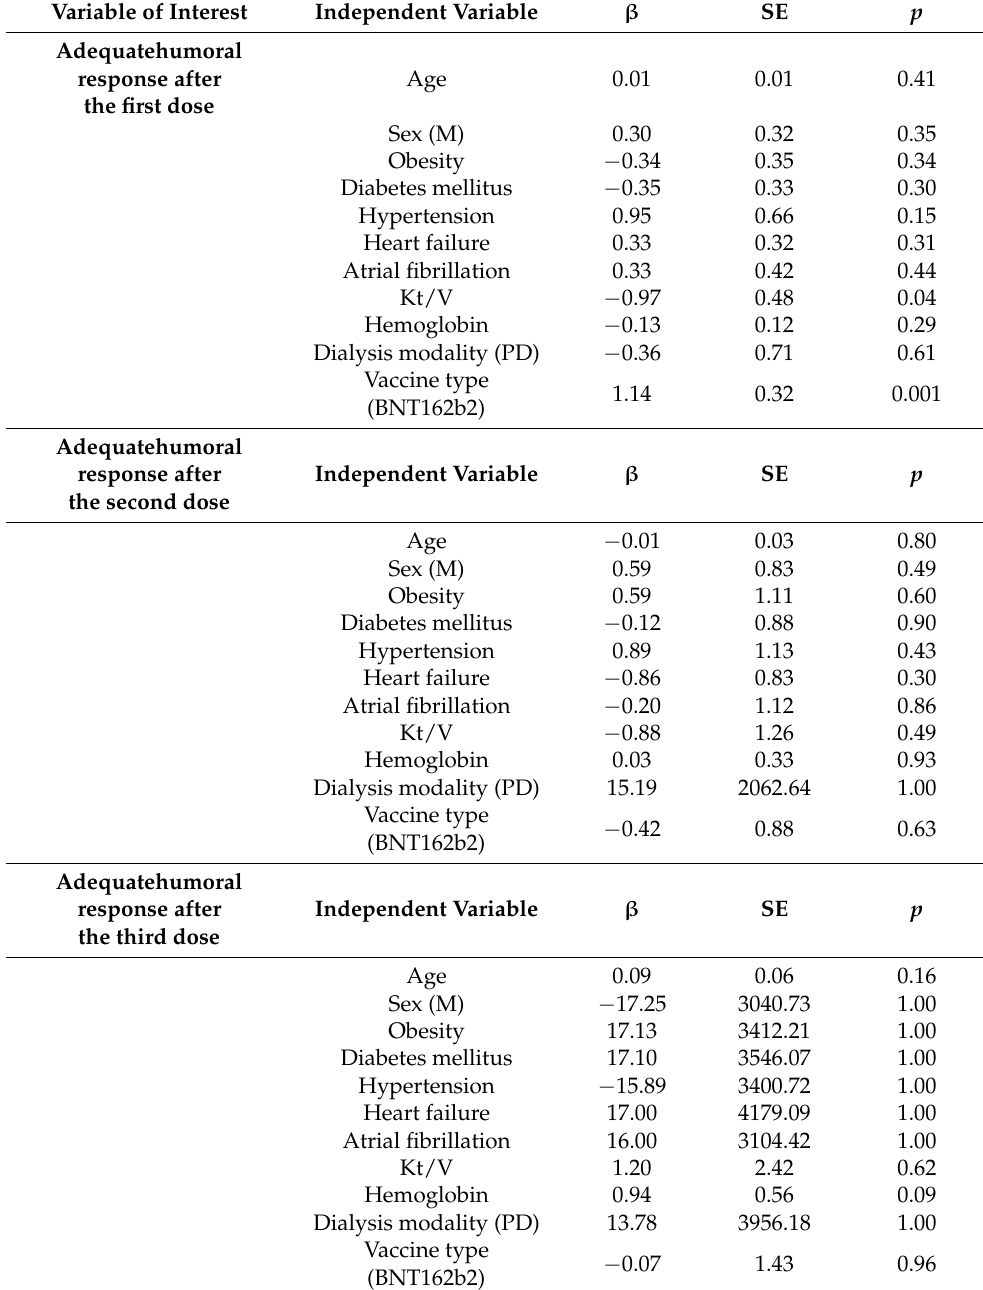
Table 2. Predictors of adequate humoral response after the 1st, 2nd and 3rd vaccine